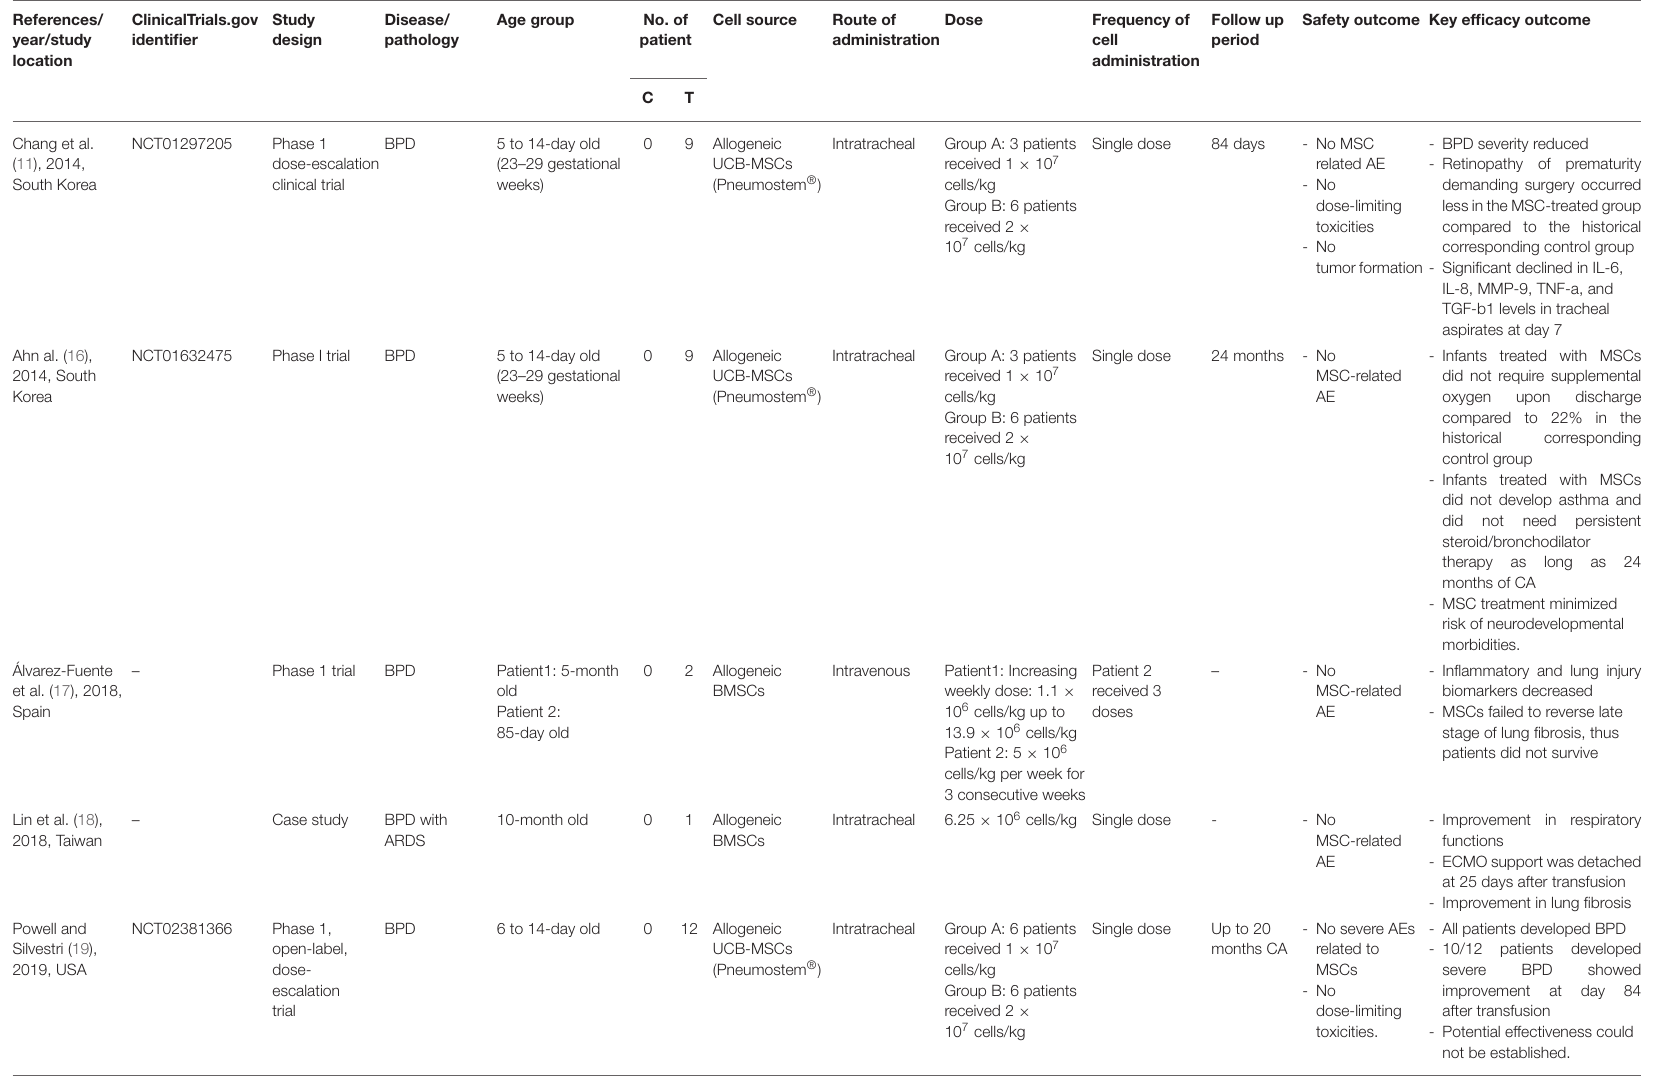
TABLE 2 | Clinical trials used MSCs to treat neonatal